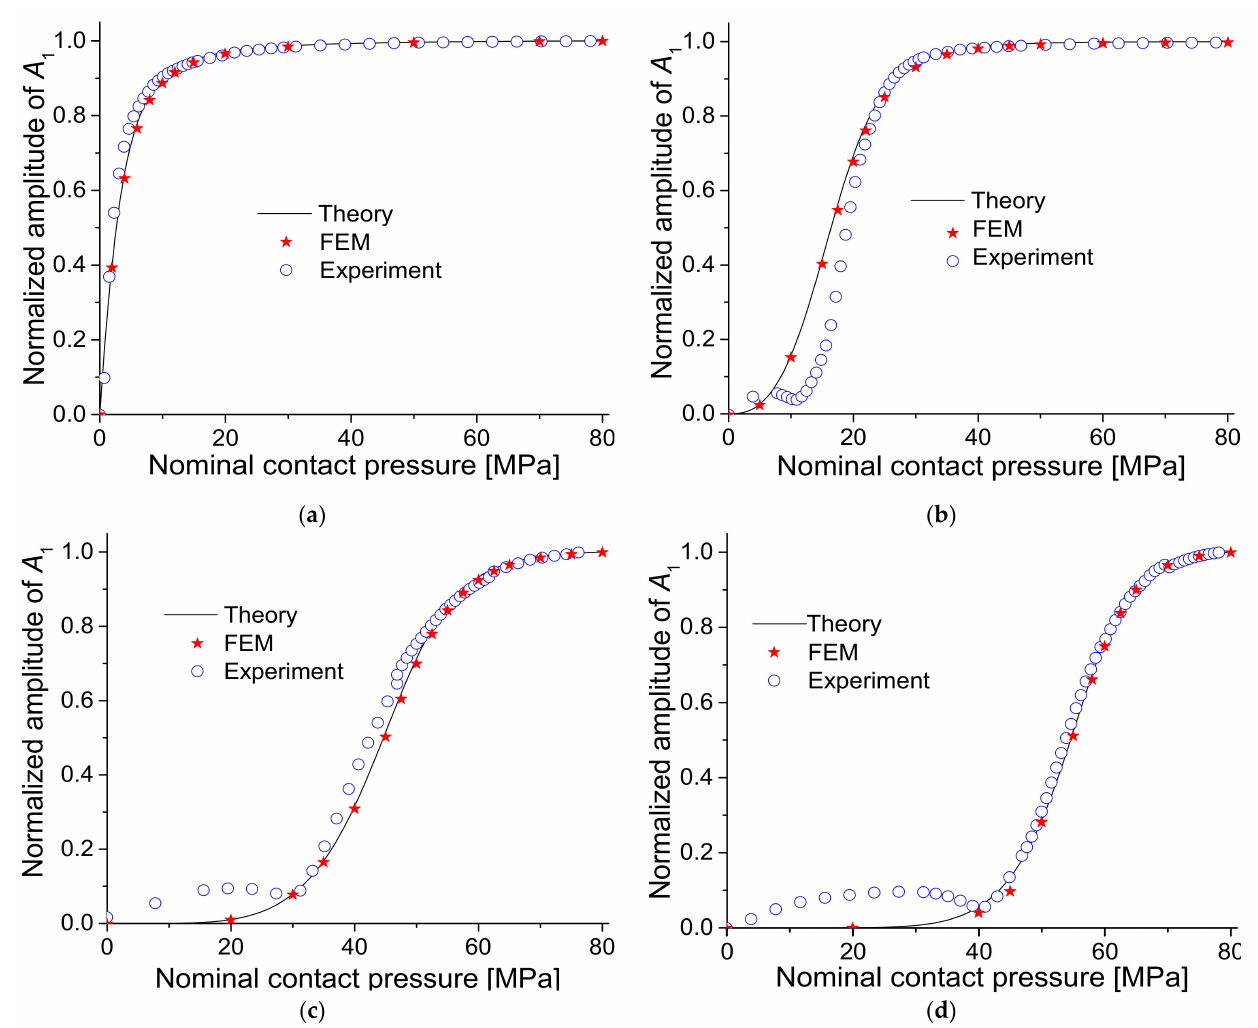
Figure 13. Comparison of theoretical, FEM, and experimental results for A 1 : ( a ) specimen 1, ( b ) specimen 2, ( c ) specimen 3, and ( d ) specimen